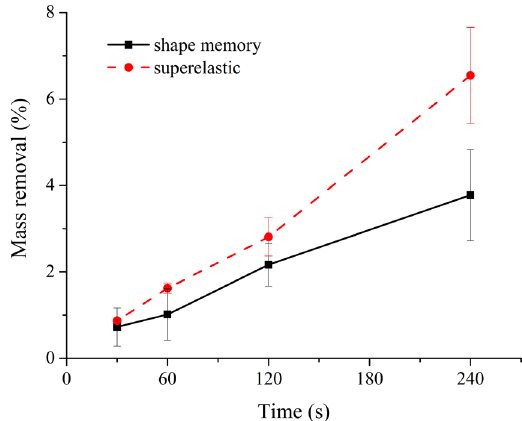
Figure 3. Mass removal percentage after polishing NiTi wires in 3.5 mol•L -1 methanolic H